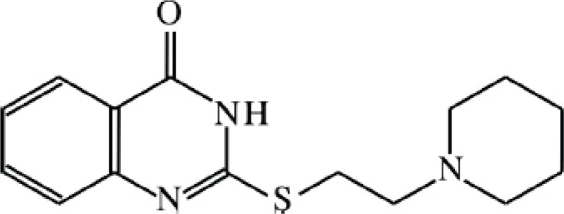
Chemical structure of L-2286 [9].